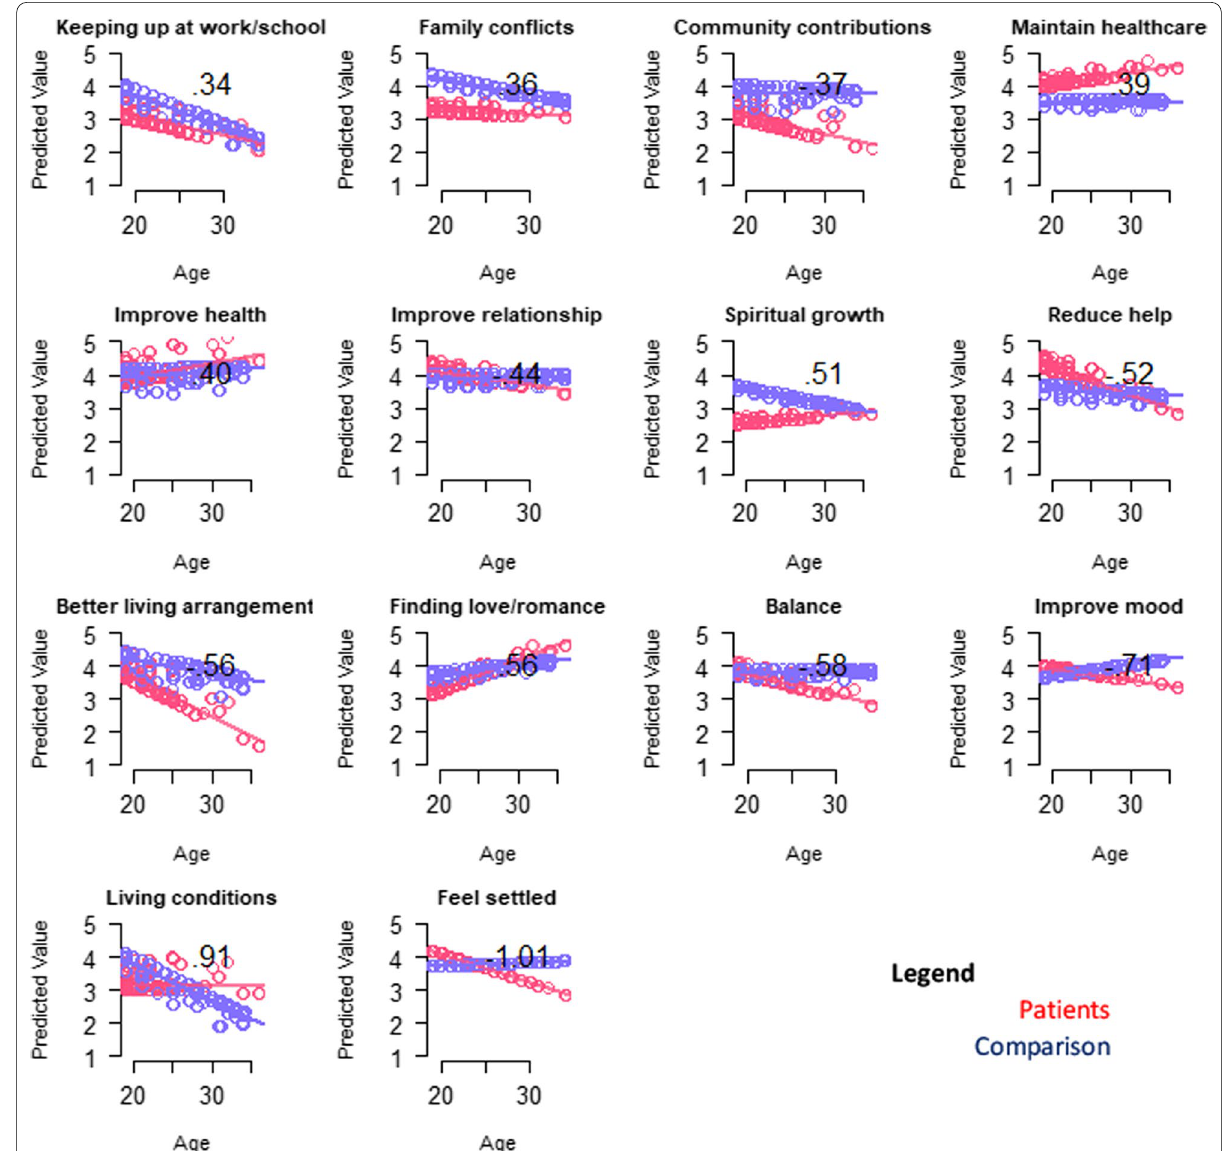
Fig. 5 Interaction plots for adjusted ANCOVA models predicting Goal items. Role-group differences for medium- and large-ES interaction effects are shown. Patient predicted values are shown in red; comparison in